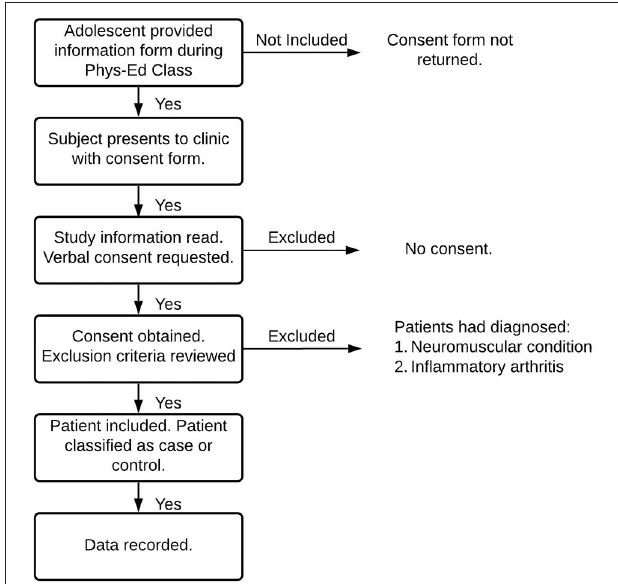
FIGURE 1 | Inclusion Criteria Flowchart. During their Phys. Ed. class, adolescents were provided an information form regarding the protocols and purpose of the current study. Written, informed parental consent and adolescent assent were acquired at a subsequent clinic. Adolescents with diagnosed inflammatory arthritis or any diagnosed neuromuscular conditions were excluded from the